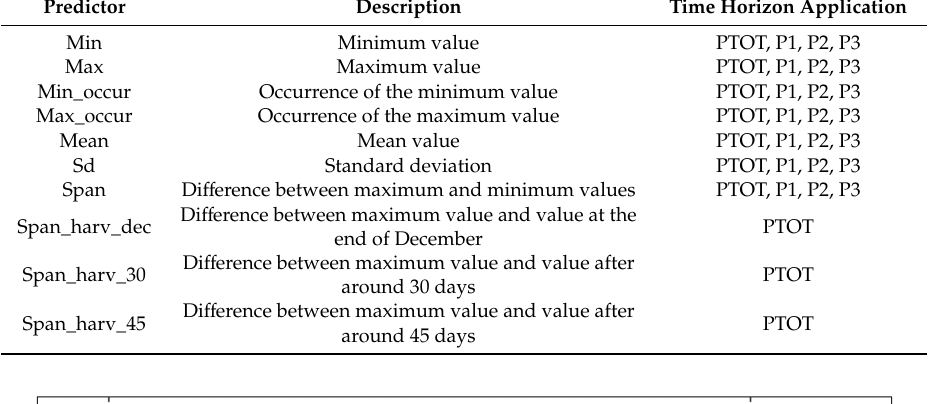
Table 2. Predictors extracted from yearly S1 VV and VH backscattering coe ffi cients and S2 NDVI